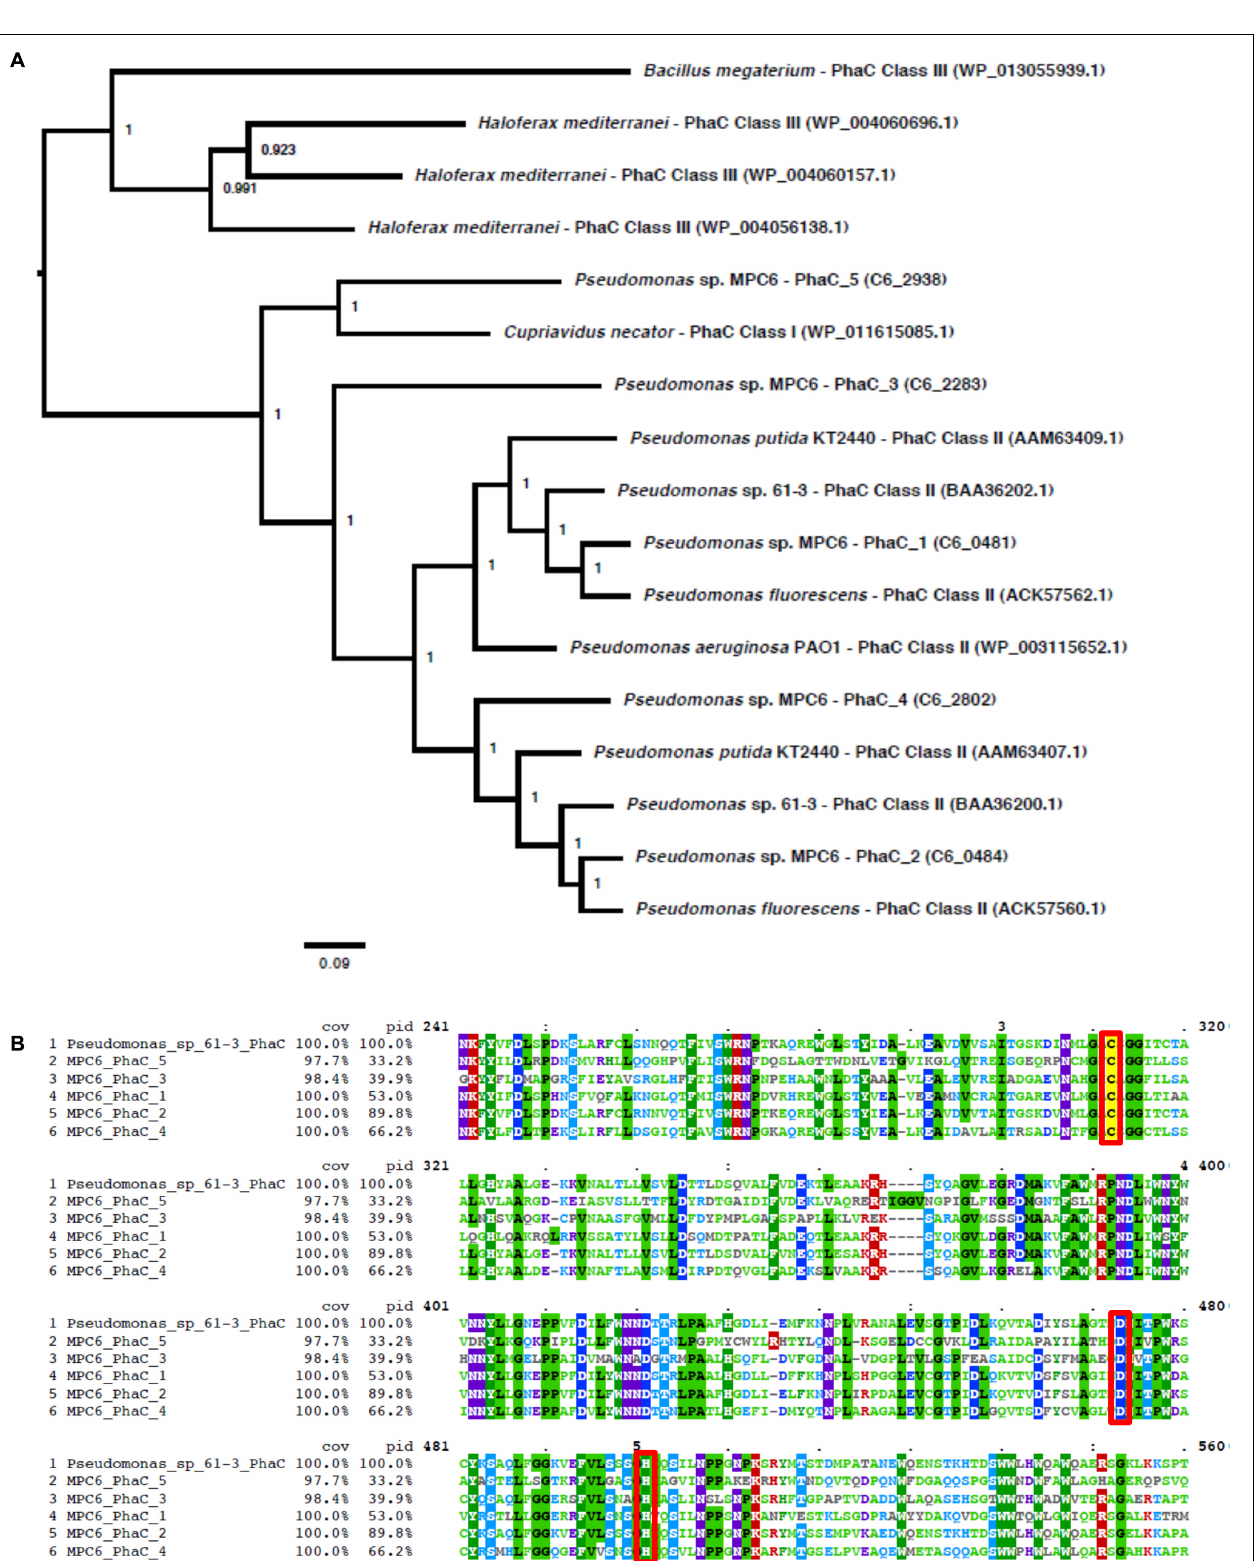
Frontiers in Microbiology |